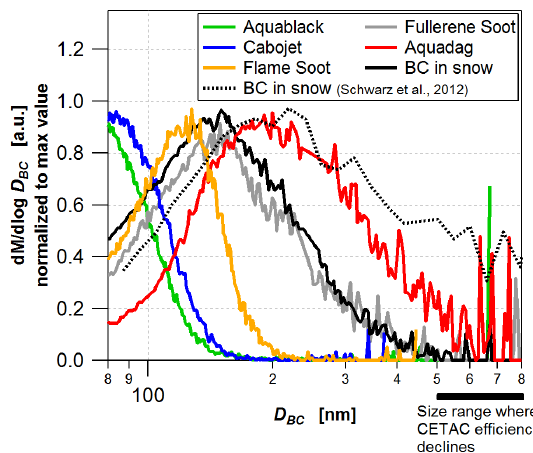
Figure 3. Average mass size distributions of various BC materials measured with the CETAC/SP2-setup at CWU – Aquadag, Cabo- jet 200, Aquablack 162, flame soot, fullerene soot and BC in snow (Blewett Pass, WA, USA). Large particles were allowed to settle out of the fullerene soot sample prior to measurement according to Schwarz et al. (2012). The curve from Schwarz et al. (2012) is added to illustrate the variability of the BC mass size distribution in snow. The lower limit of the horizontal axis is set at 80nm because this is the lower limit of reliable internal calibration and detection efficiency of the